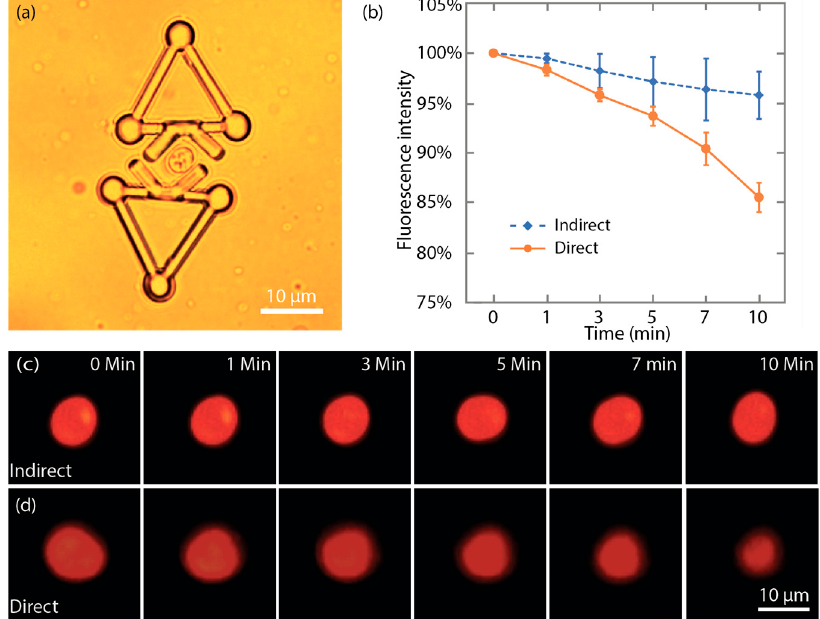
Figure 13. Indirect optical manipulation induced less photobleaching. ( a ) One cell was trapped by two microtools for fluorescence imaging. ( b ) Plot of time-dependent change of the fluorescence intensity under direct and indirect optical manipulation. ( c ) Fluorescent images of the mitoTracker Red probe stained cell during the indirect optical manipulation. ( d ) Fluorescent images of the mitoTracker Red probe stained cell during the direct optical manipulation.